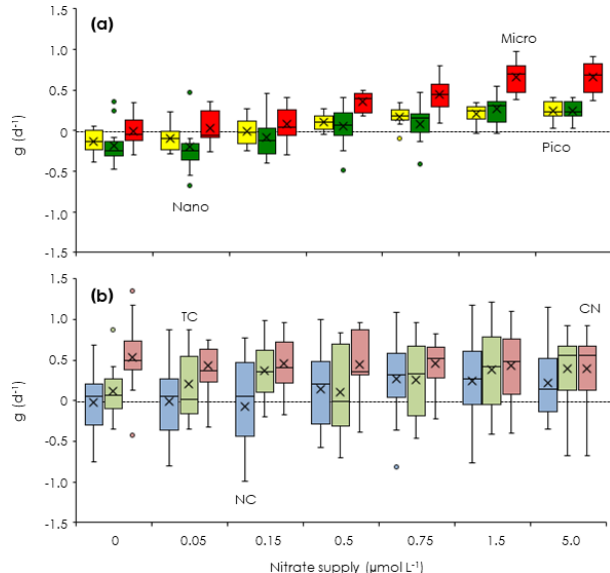
Figure 4. Changes in phytoplankton and microsized heterotroph growth rates in response to nitrate enrichments in the gradient- enrichment experiments (EXP a ). (a) Growth rates ( g : d − 1 ) of size-fractionated chlorophyll. (b) Microheterotroph growth rates ( g : d − 1 ). 0: no enrichment. 0.05 to 5.0µmolL − 1 : enrichment. Box- and-whisker diagram at each nitrate concentration is based on the results conducted at the eight stations. The symbols have the same meaning as in Fig.